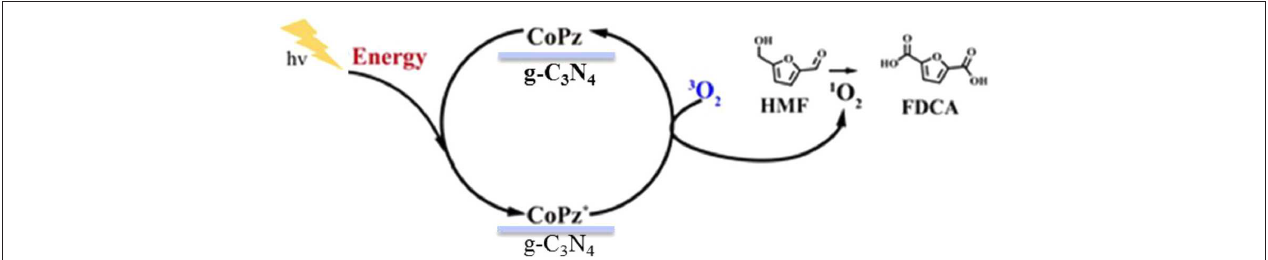
FIGURE 7 | Possible mechanism of the photocatalytic oxidation of HMF into FDCA with the CoPz/g-C 3 N 4 catalyst. Reprinted with permission from Xu et al. (2017) American Chemical Society.